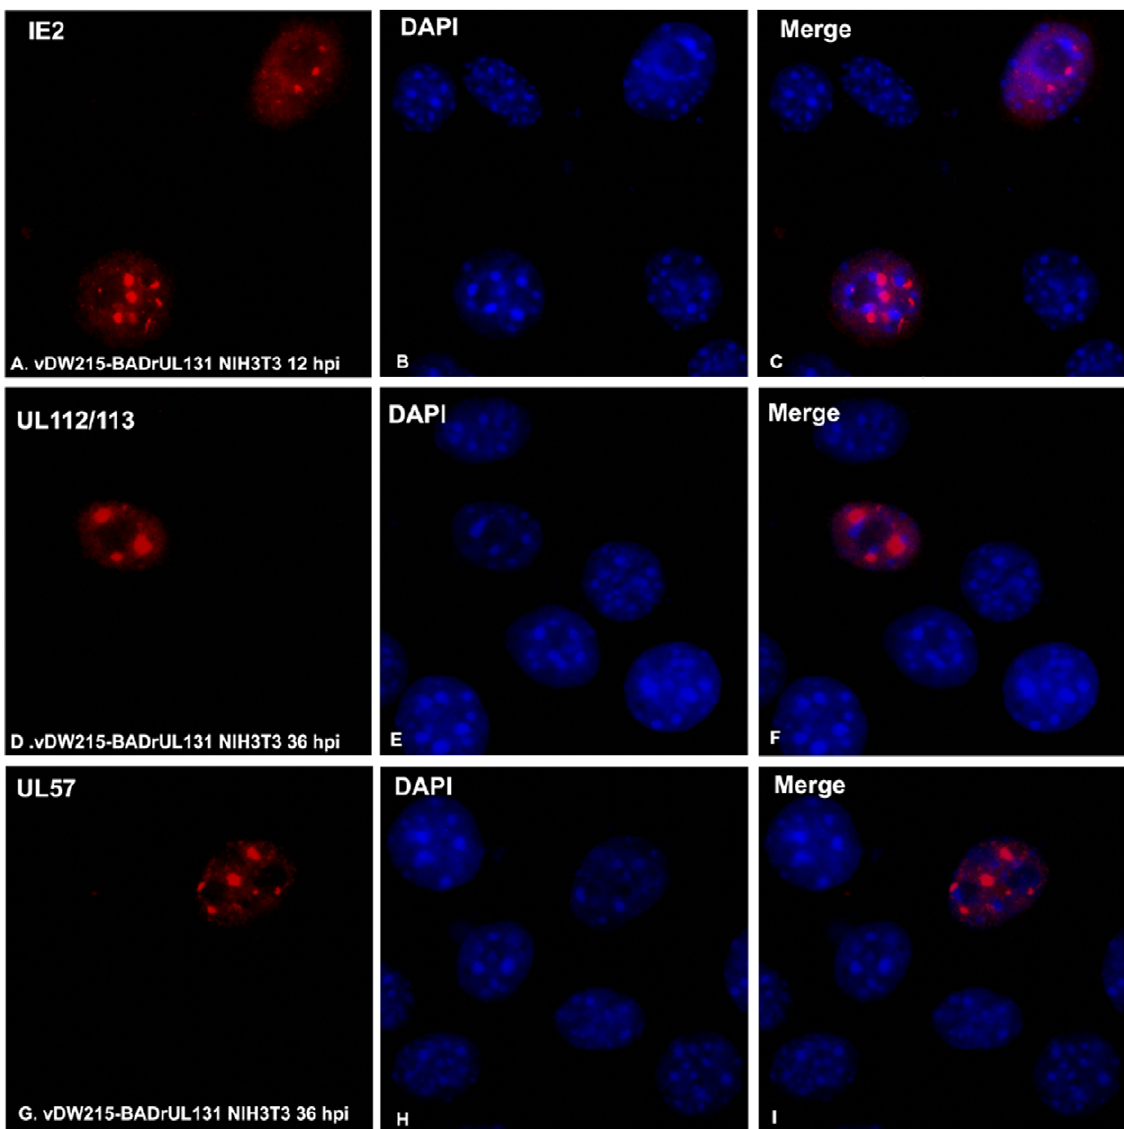
Figure 5. Immunofluorescent assay to detect HCMV proteins after infection in mouse cells. A–C: Detection of HCMV IE2 in red (A), DAPI to show total cells (B), and the two merged in C. D–F: Detection of UL112/113 in red (D), DAPI to show total cells (E), and the two merged in F. G–I: Detection of UL58 in red (G), DAPI to show total cells (H), and the two merged in I.